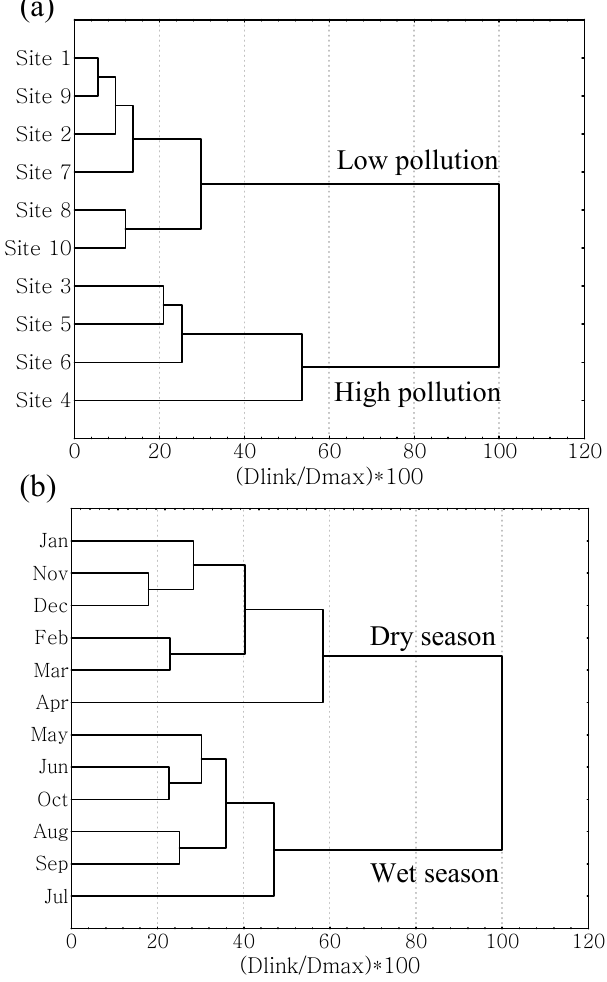
Figure 2. Dendrograms showing ( a ) spatial clustering of sampling sites and ( b ) temporal clustering of monitoring